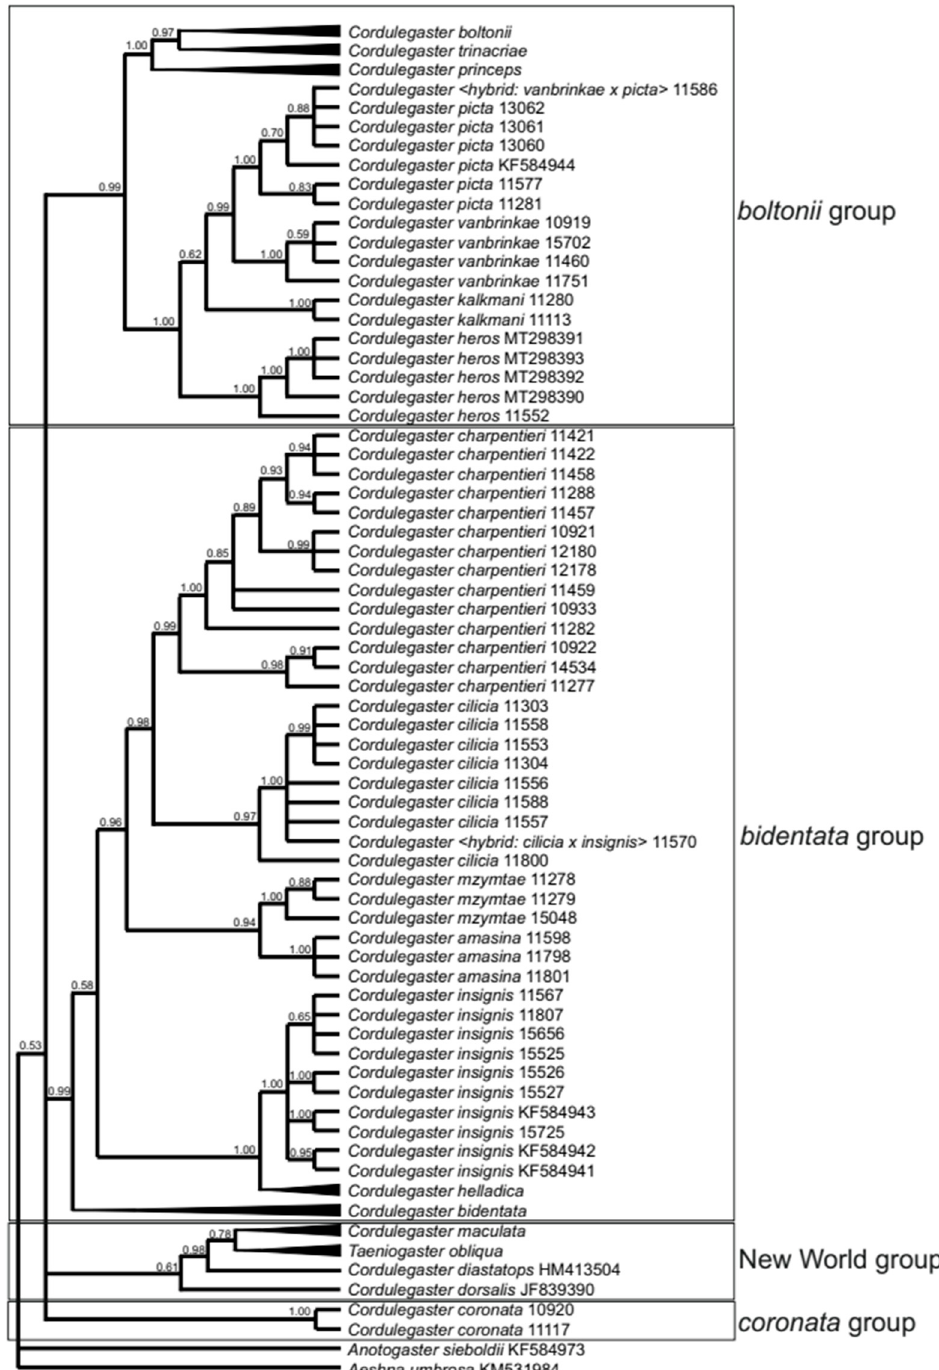
Figure 4. Overview tree for the COI gene, indicating the four major groups: boltonii -, bidentata , coronata -, New World-group. Maximum likelihood tree inferred with Bayesian analysis using MRBAYESs 3.2.7a using the best-fit model (GTR+I+G) identified with JMODELTEST 2.1.10. Bayesian posterior probabilities values are depicted at the nodes. Included are our own sequences (PCR number next to the name) and those retrieved from GenBank (accession numbers next to the name), if specimens identify different taxa in the COI and ITS analysis they are indicating possible hybrids).